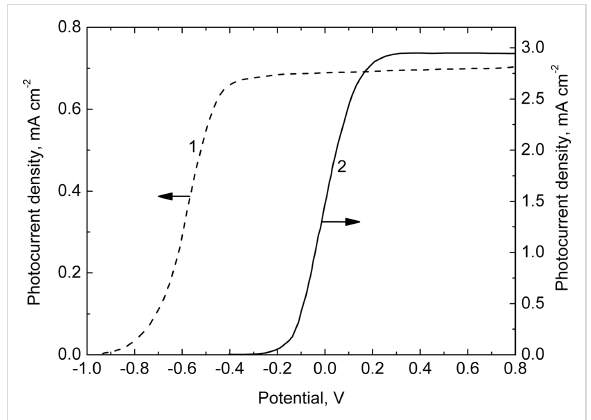
Figure 7: Photocurrent versus electrode-potential curves recorded under UV illumination of the mesoporous In 2 O 3 electrodes annealed at 200 °C (1) and 400 °C (2). Electrolyte: 0.1 M KOH solution.